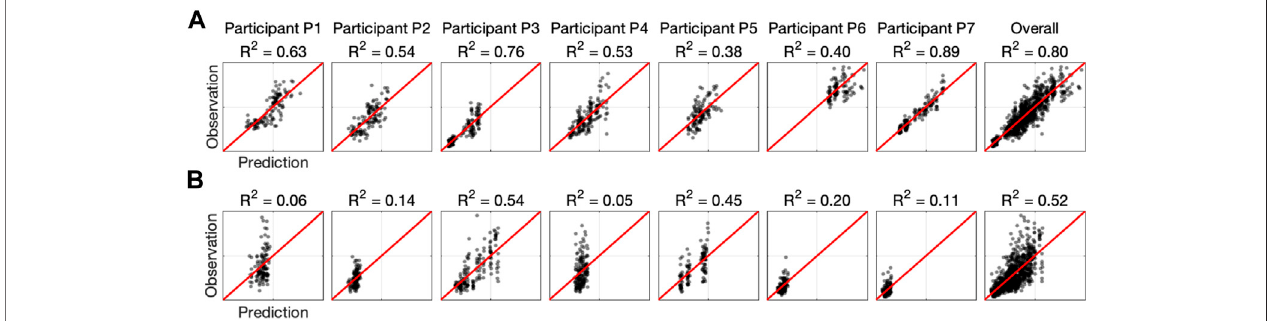
FIGURE11| Summaryoflinearmixed-effectsmodel fi ts.Eachplotshowstheobservations versus predictionsforeachparticipantandoverall.Theredlinedenotes the perfect model. (A) Model with effort as the outcome variable. (B) Model with error as the outcome variable.